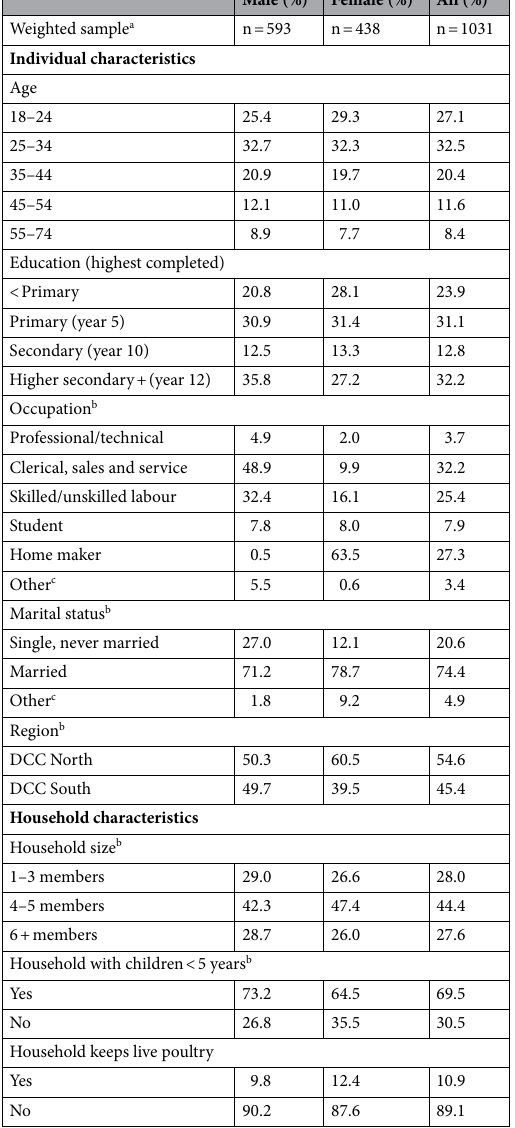
Table 1. Demographic and household characteristics of participants, by sex, Dhaka City Corporation, Bangladesh. CI confidence interval, yrs years, DCC Dhaka City Corporation. a Sample weighted by age, sex and education to the Dhaka City Corporation demographic profile of the 2011 Bangladesh census. b Due to missing values, total weighted denominator for occupation n = 1024; marital status n = 1025; region n = 1009; household size n = 1025; children n = 1017. c Other occupation includes retired and unemployed; other martial status includes widow/widower and